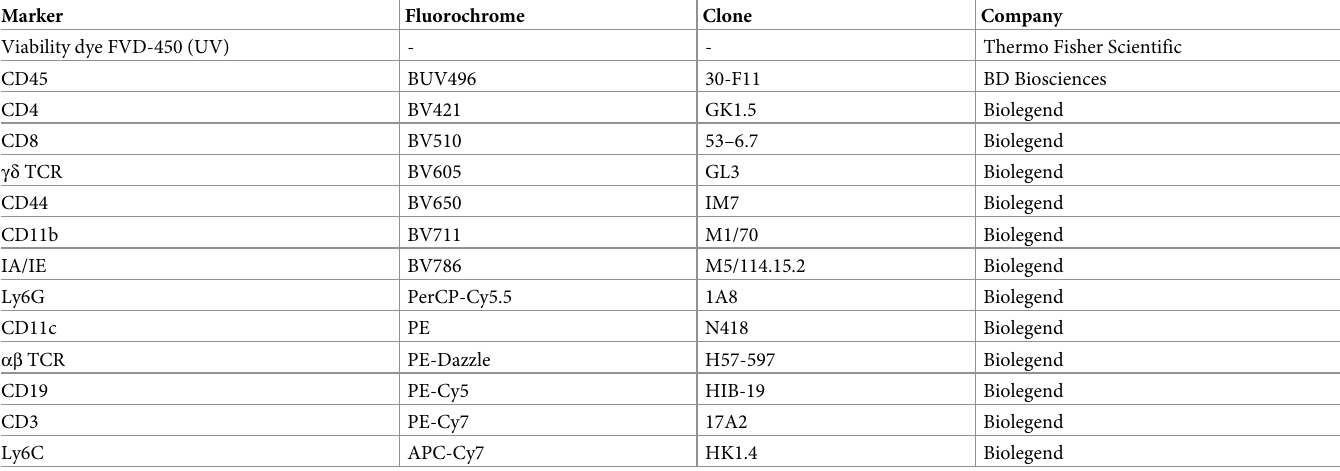
Table 1. Surface marker antibodies for flow